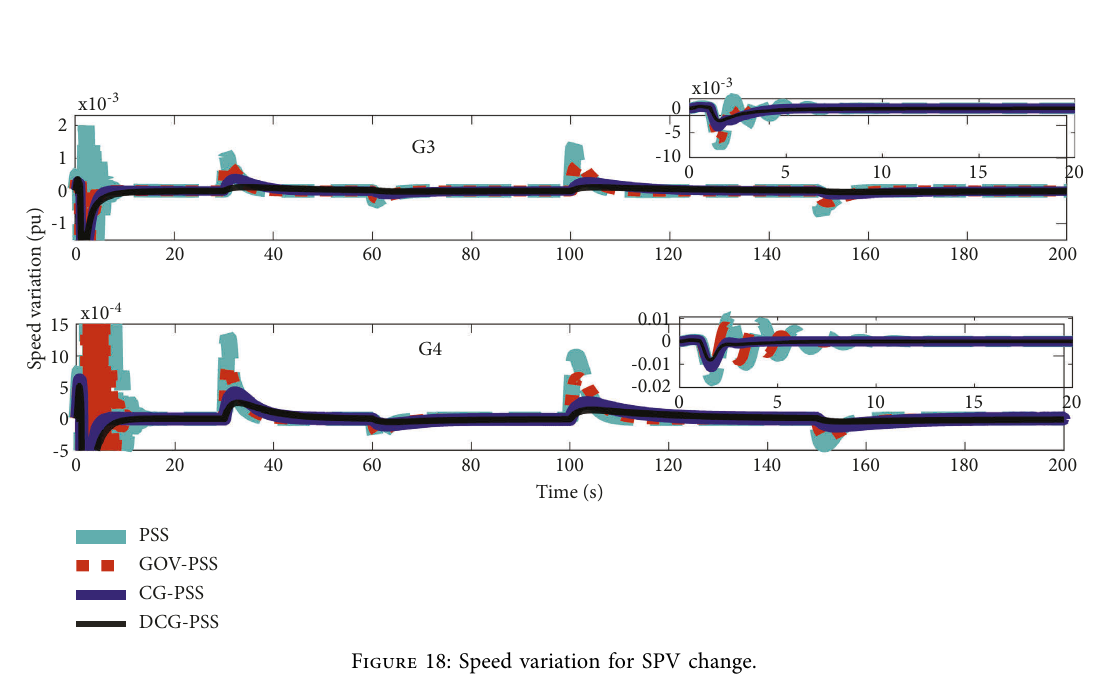
Figure 17: Speed variation for SPV change.